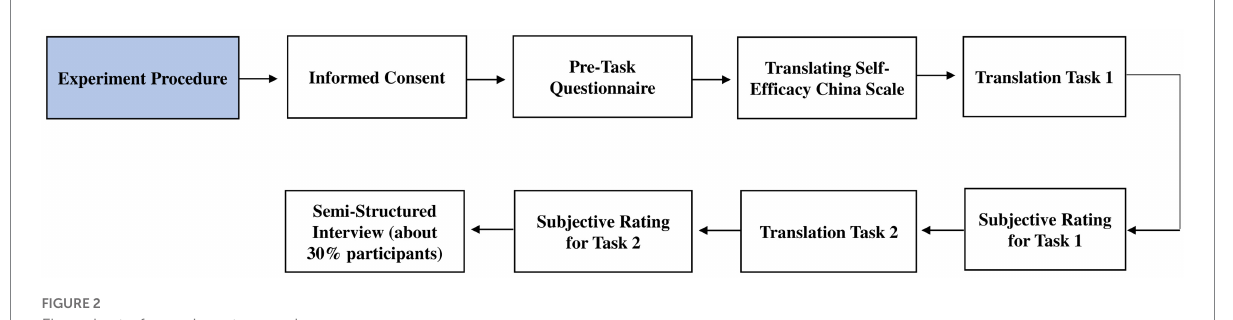
FIGURE 2 Flow chart of experiment procedure.